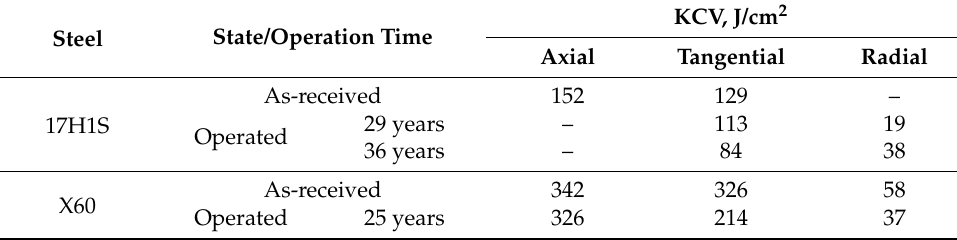
Table 2. Impact toughness of steels for different specimen orientation relative to the pipe axis.